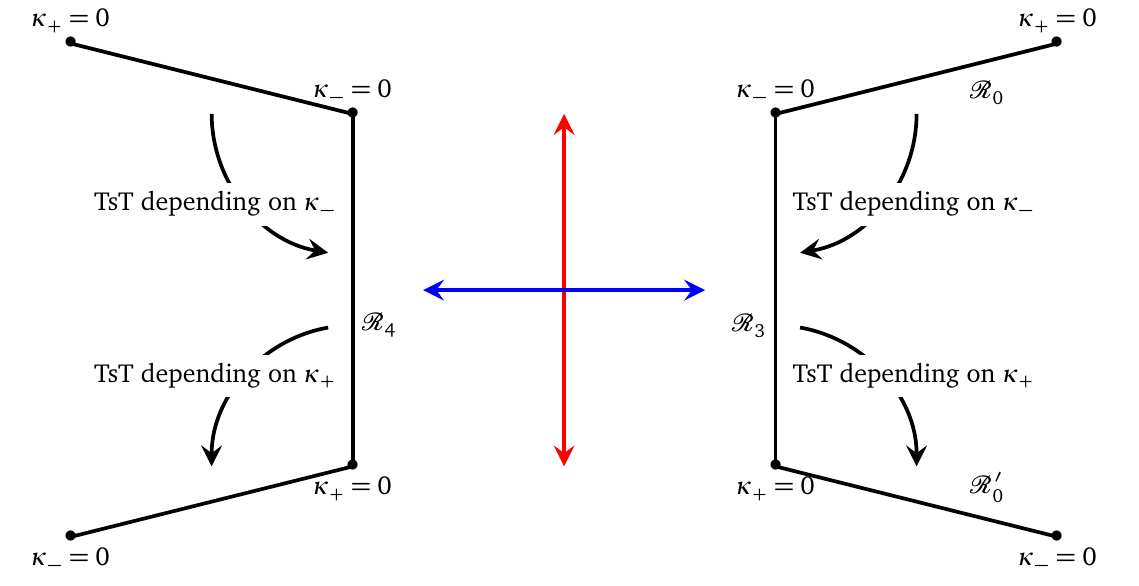
Figure 2 . A window into the space of generalised supergravity backgrounds for the two-parameter deformation of the AdS 3 (cid:2) S 3 (cid:2) T 4 superstring. The two vertical lines in the middle represent the two backgrounds based on R-matrices associated to the Dynkin diagram ( (cid:10) (cid:0) (cid:0) (cid:10) ) 2 , namely R 3 and R 4 . The top right and bottom right tilted lines correspond to the two backgrounds based on # R-matrices associated to the Dynkin diagram ( (cid:0) (cid:10) (cid:0) ) 2 , namely R 0 and R 0 . The transforma- 0 tion (3.13) (respectively (3.14)) is represented by the blue (respectively red) arrow. (3.14) leaves # # the two backgrounds corresponding to R 3 and R 4 invariant and swaps the two backgrounds cor- responding to R 0 and R 0 . The transformation (3.13) swaps the backgrounds corresponding to R 3 0 and R 4 but does not leave the backgrounds associated to R 0 or R 0 invariant. Rather it generates 0 new generalised supergravity backgrounds (the two tilted lines on the left). It is not clear if these also correspond to particular Drinfel’d Jimbo R-matrices. Of course, since they are obtained from the R 0 and R 0 backgrounds by a (cid:12)eld rede(cid:12)nition they are also related to the R 4 background by 0 TsT transformations on the